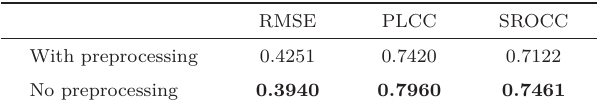
Table 6 RMSE, PLCC, and SROCC for the testing dataset of our DIBR synthetic image database with different network Table 5 RMSE, PLCC, and SROCC for the testing set of our DIBR synthetic image database with different preprocessing strategies RMSE PLCC